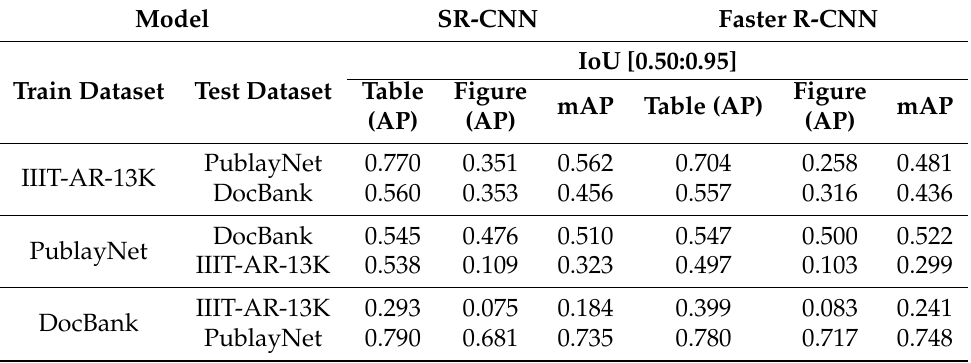
Table 11. The cross-dataset evaluation results for the SR-CNN and baseline Faster R-CNN models. We evaluate the models on the common classes of IIIT-AR-13k, PubLayNet, and